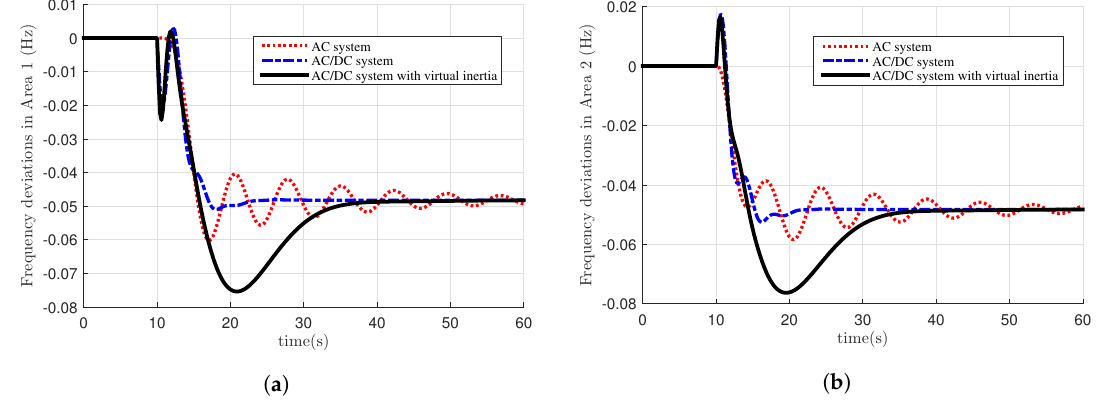
Figure 7. Results of both areas under a univariate attack with a magnitude of 0.1Hz on the measurement of frequency in Area 2, at t = 10s. ( a ) Frequency deviation of Area 1. ( b ) Frequency deviation of Area 2.